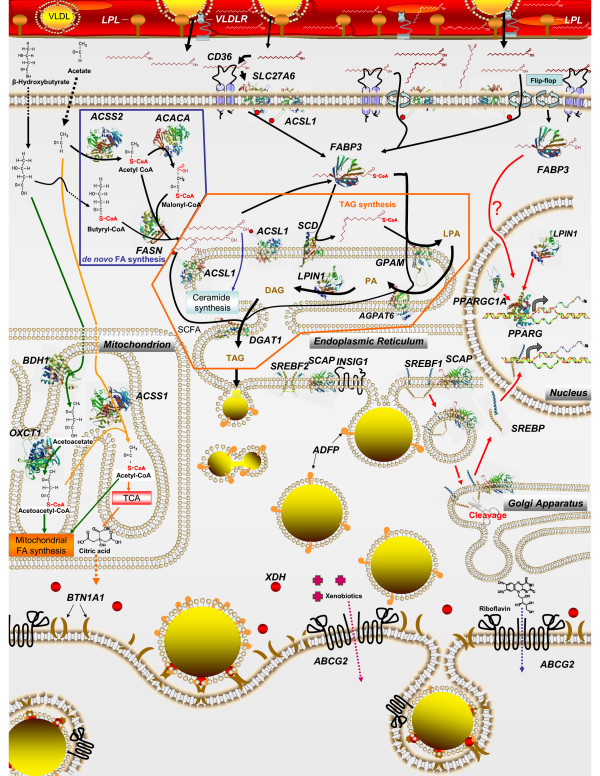
Interrelationships among cellular pathways regulating milk fat synthesis in bovine mammary tissue. Detailed description of the model is reported in the discussion section. Protein structures, when available, are the most updated from ModBase .